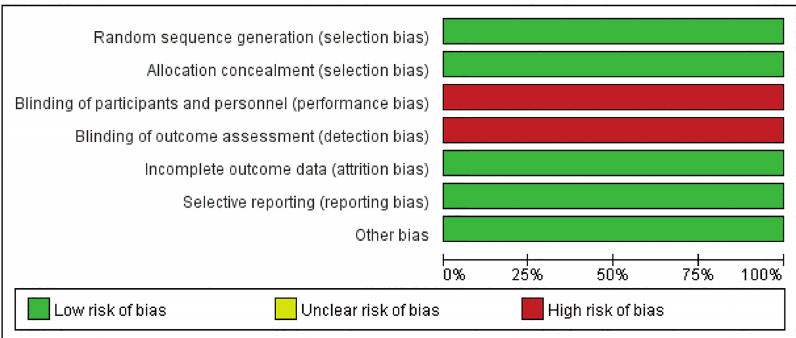
Table 3. Results of the JBI cross-sectional survey bias risk